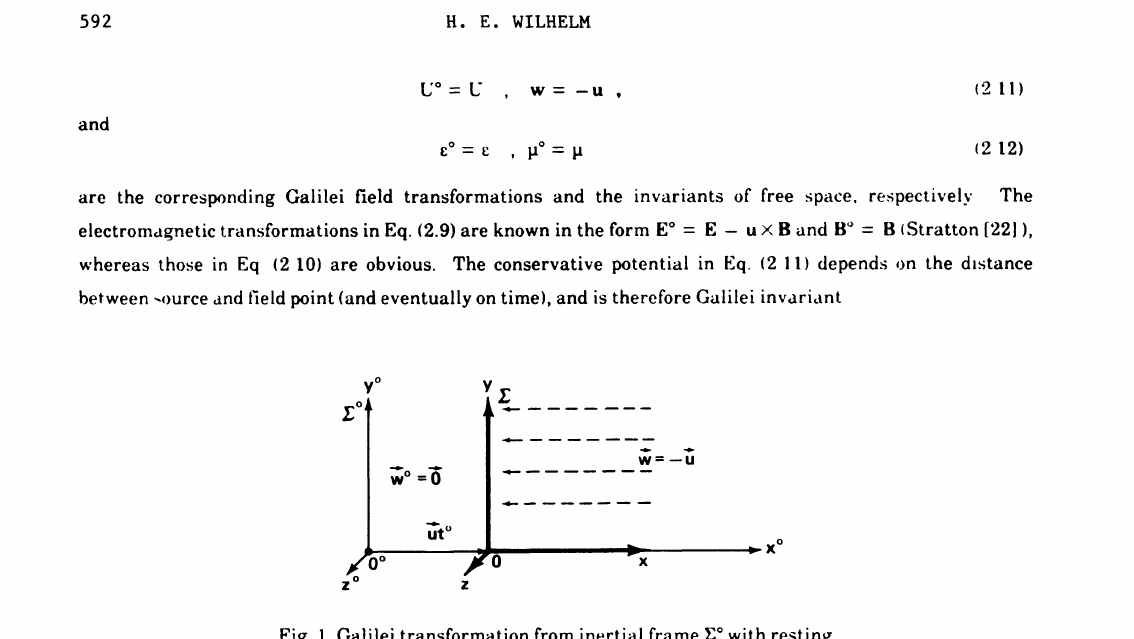
Fig 1. Galilei transformation from inertial frame I with resting substratum to an inertial frame with streaming substratum w u, where 1J moves relative to I: with velocity u(0 0 for